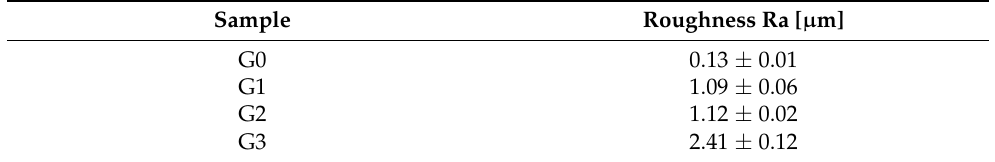
Table 2. Coatings surface roughness.